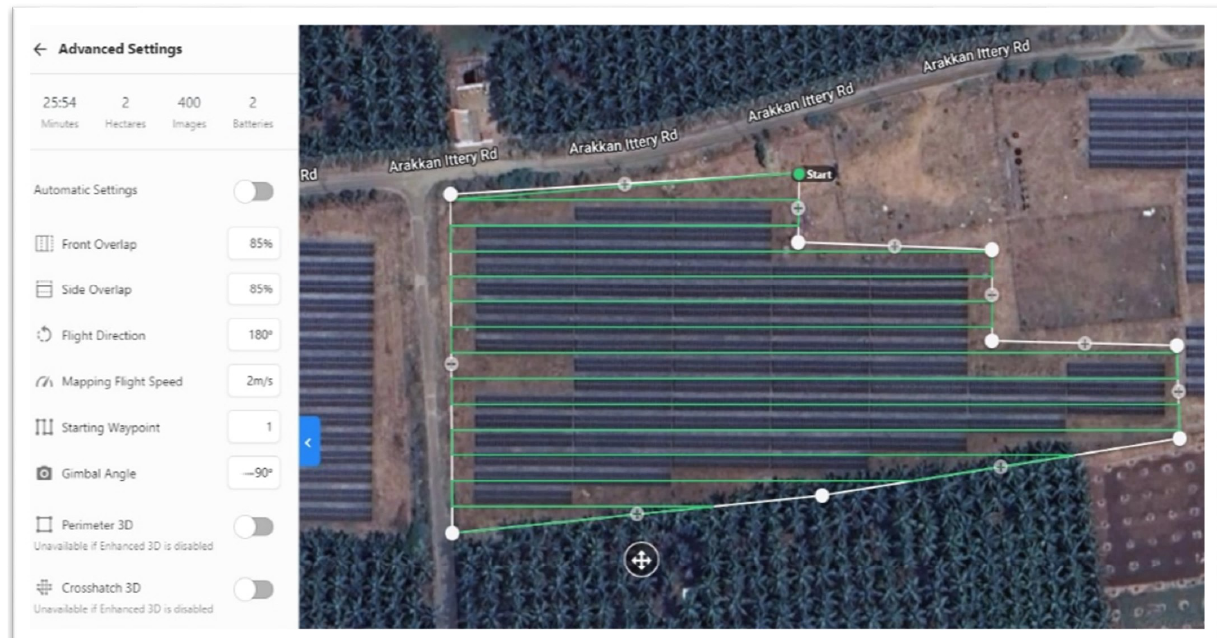
Figure 2. Grid Path Pattern, Images: Drone